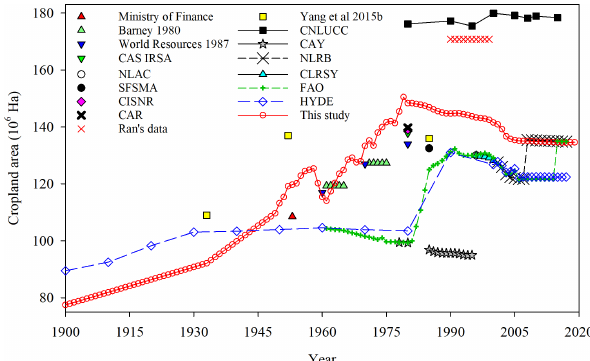
Figure 2. Comparisons of national cropland area data from differ- ent sources. The abbreviations used in the figure are as follows: Barney 1980 denotes the number from Barney (1981); World Re- sources 1987 refers to World Resource Institute (1987); NLAC de- notes the National Land Administration of China; SFSMA denotes the Soil Fertility Station of the Ministry of Agriculture; CAS IRSA refers to the Institute of Remote Sensing and Digital Earth, Chi- nese Academy of Sciences; CISNR denotes the Committee of In- tegrated Survey of Natural Resources; CAR denotes the Commit- tee of Agricultural Regionalization; NLRB refers to the National Land and Resources Bulletin; CLRSY denotes the China Land and Resources Statistical Yearbook; Ran’s data refers to the average of the five datasets prepared by Ran et al. (2010) and Ran (2013), in- cluding the IGBP Data and Information System, UMD Land Cover, GLC2000, CAS1990, and the WESTDC Land Cover Product 2.0; CNLUCC denotes the China Land Use and Cover Change dataset obtained from the Data Center for Resources and Environmental Sciences, Chinese Academy of